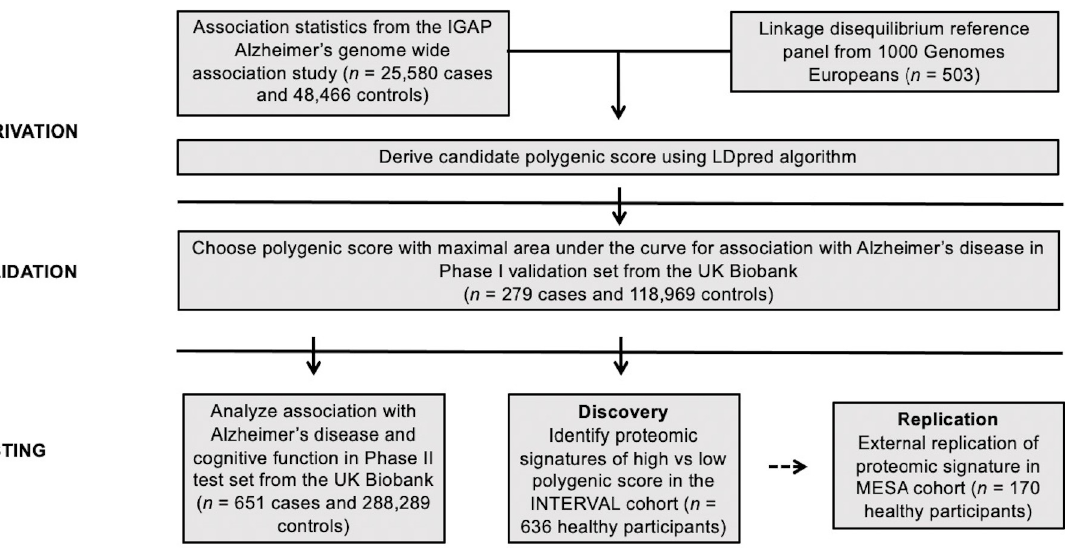
Fig 1. Study Design and Workflow. Using previously published genome-wide association study summary association statistics [26] and a linkage disequilibrium reference panel of 503 European-ancestry participants from the 1000 Genomes study [27], we derived six candidate polygenic scores for Alzheimer’s disease using the LDPred computational algorithm [28]. The best performing polygenic score was selected based on maximal area-under-the curve in a validation dataset derived from the UK Biobank [29] (n = 119,248 European-ancestry participants) and subsequently calculated in an independent set of UK Biobank participants (n = 288,940). Associations with a clinical diagnosis of Alzheimer’s and performance on a neurocognitive test were determined in both overall and in age-stratified analyses. In an independent dataset derived from the INTERVAL study of healthy blood donors [30], we compared the levels of 3,231 circulating proteins between 636 participants in the top or bottom decile of the polygenic score. We sought to replicate proteins significantly associated with the polygenic score in the INTERVAL study in participants of the MESA study. IGAP: International Genomics of Alzheimer’s Project [26]; UKBB: United Kingdom Biobank [29]; MESA: Multi-Ethnic Study of Atherosclerosis